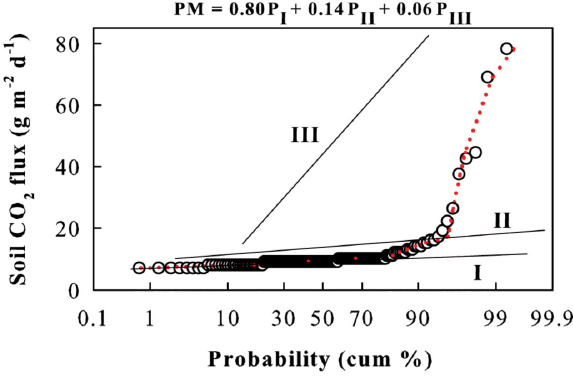
fluxes measured on the is- Figure 3. Probability plot of soil CO 2 land. The red dotted curve shows the theoretical distribution pro- duced by combining the populations in the proportions indicated by the threshold values according to the equation reported at the top of the graph. Solid lines indicate the populations reconstructed ac- cording to the procedure illustrated by Sinclair